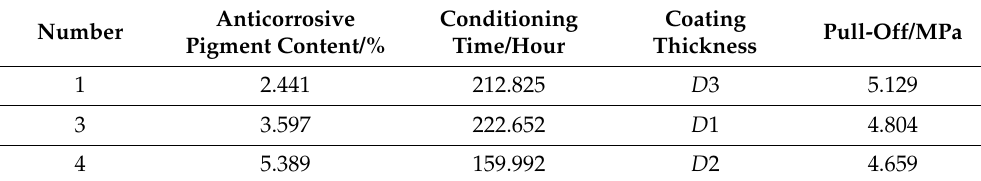
Table 8. Solution for three combinations of categorical factor